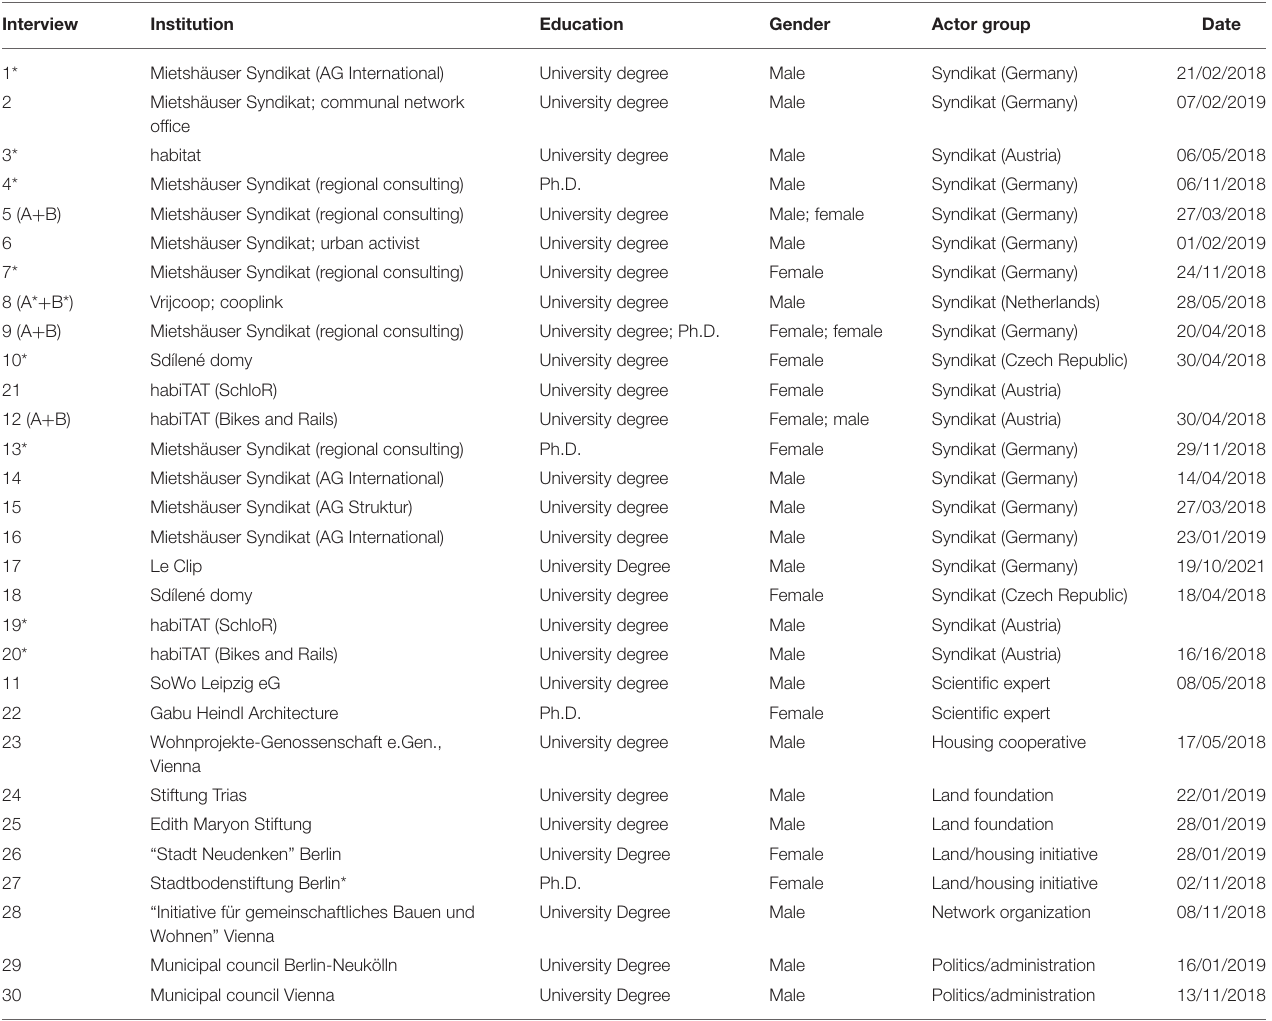
TABLE 1 | Sample of interviews